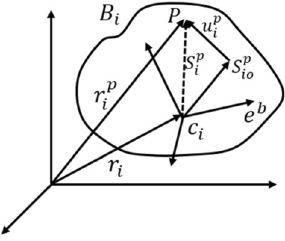
Figure 2. Single deformation body